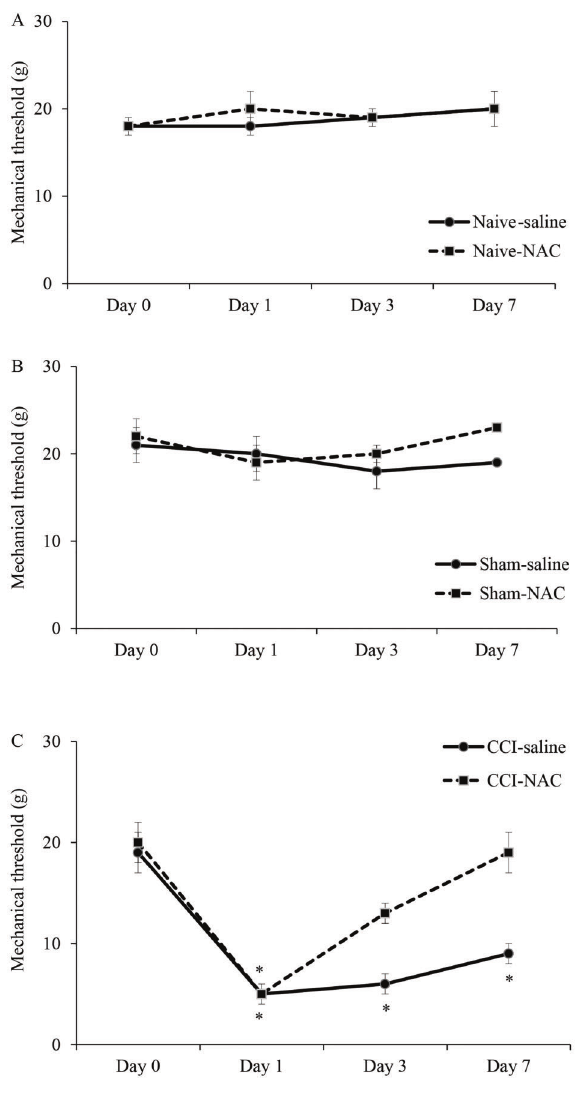
Figure 1. Assessment of mechanical threshold in rats with chronic constriction injury (CCI) of the sciatic nerve that received 2, 4, or 8 intraperitoneal injections of saline or N-acetylcysteine (NAC; 150 mg (cid:1) kg – 1 (cid:1) day – 1 ) beginning 4 h after CCI. Rats were sacri fi ced 1, 3, and 7 days after surgery. In Sham rats, all surgical procedures involved in the CCI were used except the ligature. Day 0: sensitivity assessments before the surgical procedure. Data are reported as means ± SE. *P o 0.05 compared to pre- nerve lesion values (repeated-measures ANOVA followed by Tukey post hoc test, n=6).